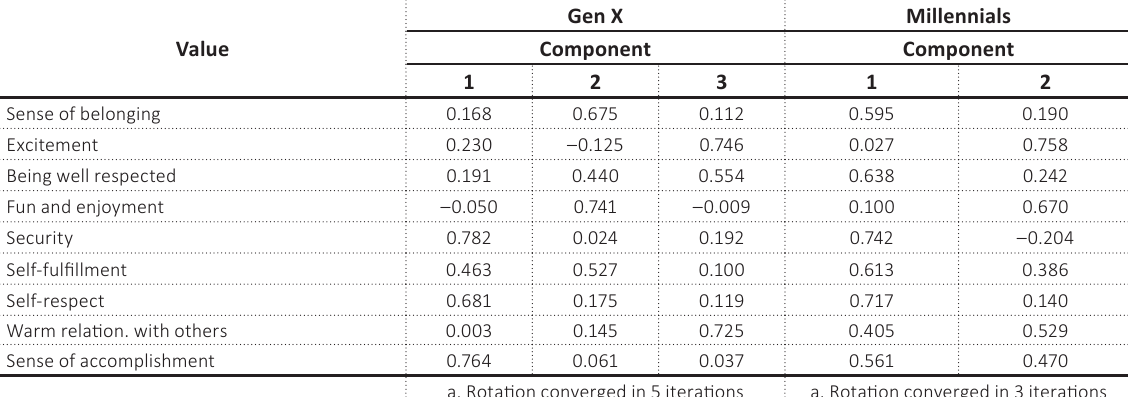
Table 2. Rotated component